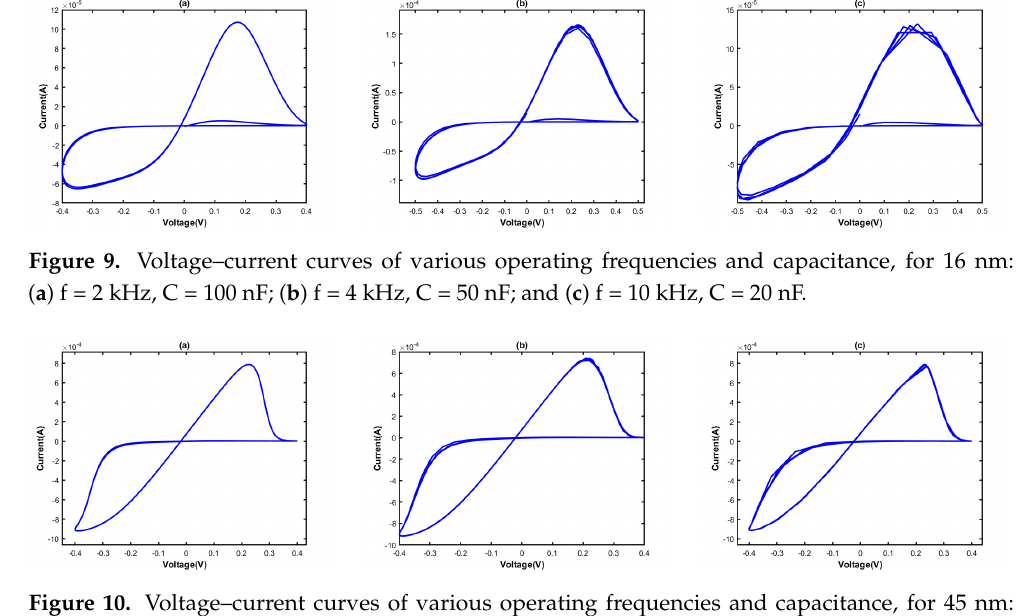
Figure 10. Voltage–current curves of various operating frequencies and capacitance, for 45